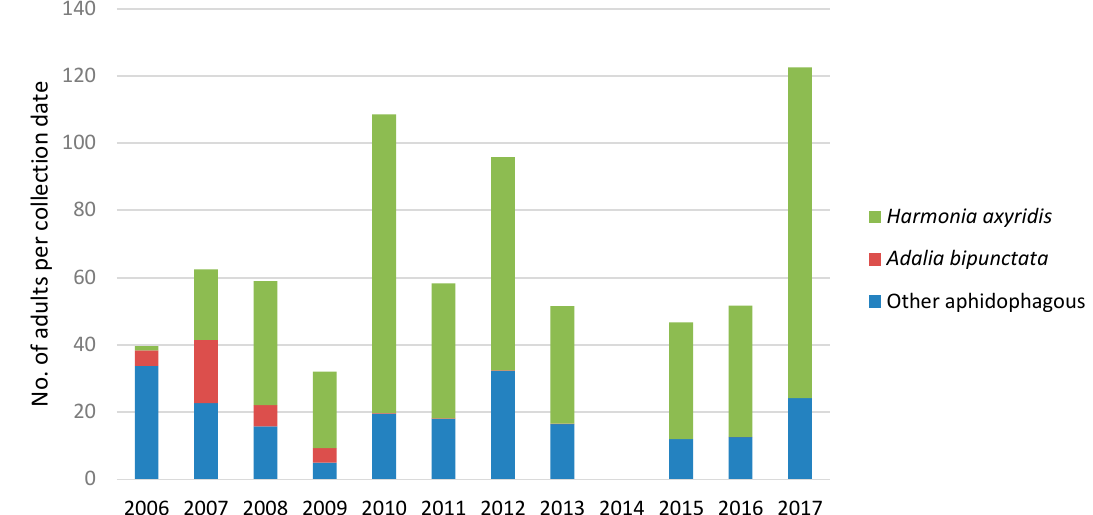
Figure 5. Number of adults of Harmonia axyridis , Adalia bipunctata and other aphidophagous ladybird species collected per collection date on 15 broadleaved hedges from 2006 to 2017.